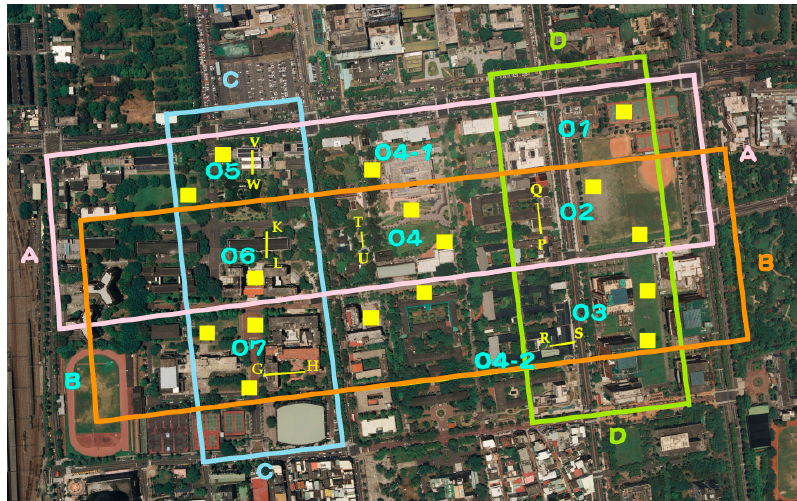
Figure 4. Four Lidar strips, namely A, B, C, and D, and six section lines, namely 𝐺𝐻(cid:3364)(cid:3364)(cid:3364)(cid:3364), 𝐾𝐿(cid:3364)(cid:3364)(cid:3364)(cid:3364),𝑃𝑄(cid:3364)(cid:3364)(cid:3364)(cid:3364) , 𝑅𝑆(cid:3364)(cid:3364)(cid:3364)(cid:3364), 𝑇𝑈(cid:3364)(cid:3364)(cid:3364)(cid:3364), and 𝑉𝑊(cid:3364)(cid:3364)(cid:3364)(cid:3364)(cid:3364) . Yellow squares denote the check planes for calculating the absolute deviation (ABD) indicator.